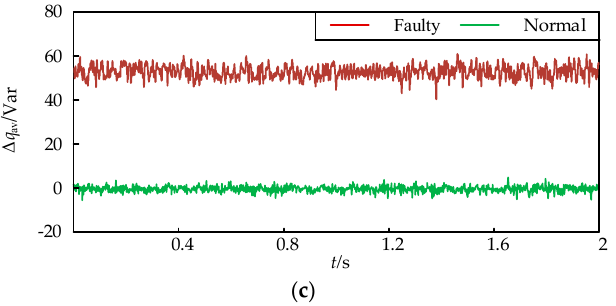
Figure 15 . The experimental result: ( a ) the instantaneous reactive power q of two sets; ( b )The difference Δ q of two sets; ( c ) the ∆ q av . In order to observe clearly, the waveforms in 10 electrical cycles (1.00~1.20 s) in the experiment